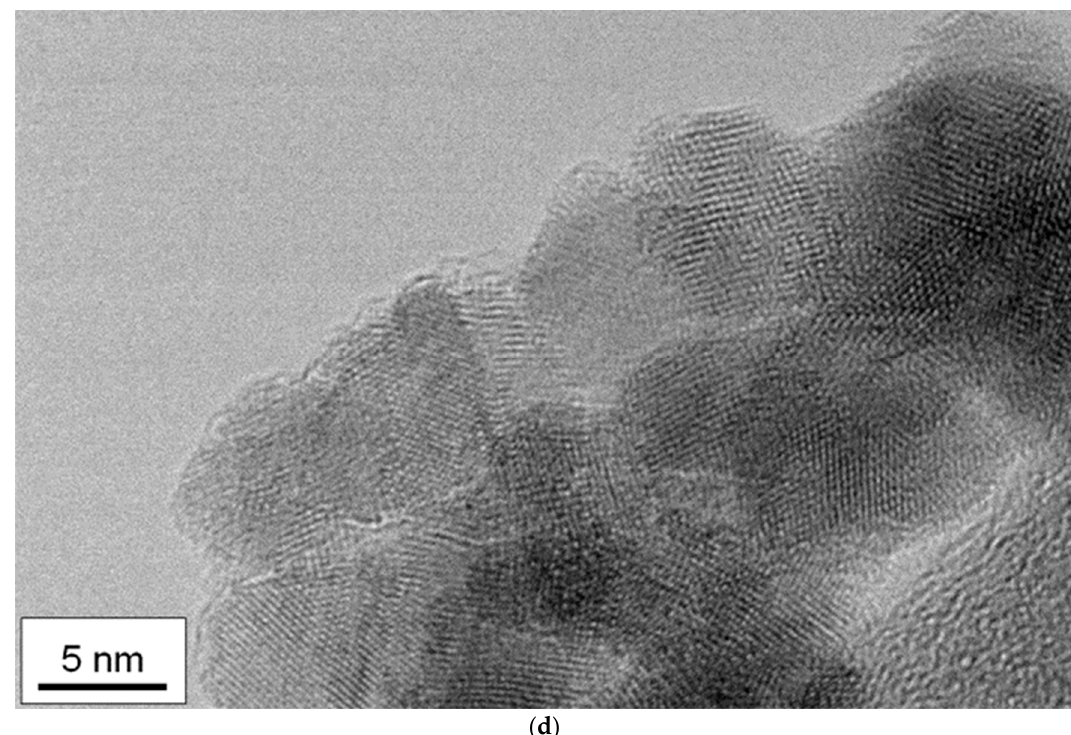
Figure 4. TEM images of the Sn/Ti oxide sample treated at 500 °C in air. The ratio of Sn/Ti in the precursor solution was 50:50. The period of maximum temperature in the sintering was 2 h. ( a , b ) Lower-resolution images of the Sn/Ti oxide sample. Inserted image in ( a ) presents the Selected Area Diffraction (SAD) pattern corresponding to the observed area of interest highlighted with a dotted orange circle. ( c , d ) High-resolution TEM images (HR-TEM) measured at two different positions. Figure ( c ) shows a d -spacing for the observed lattice fringes and lattice planes corresponding to (110) and (101) of SnO 2, and (110) of TiO 2 .